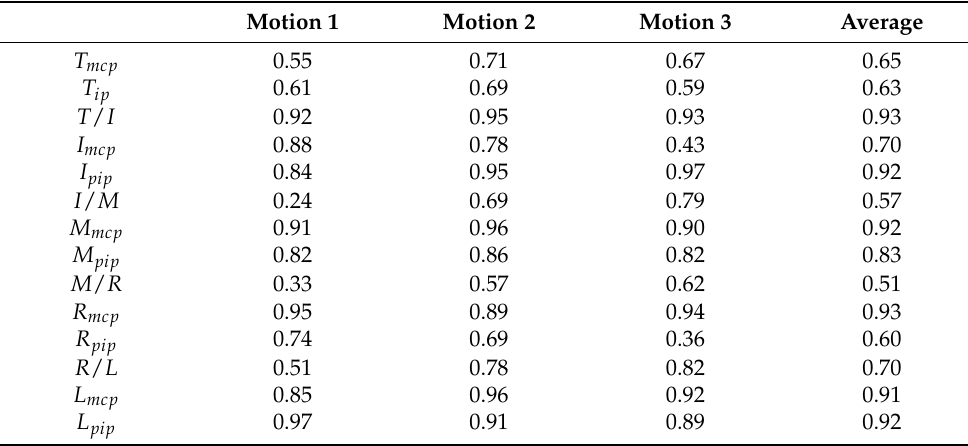
Table 4. R-squared coefficient of hand motion reconstructed by three postural synergy